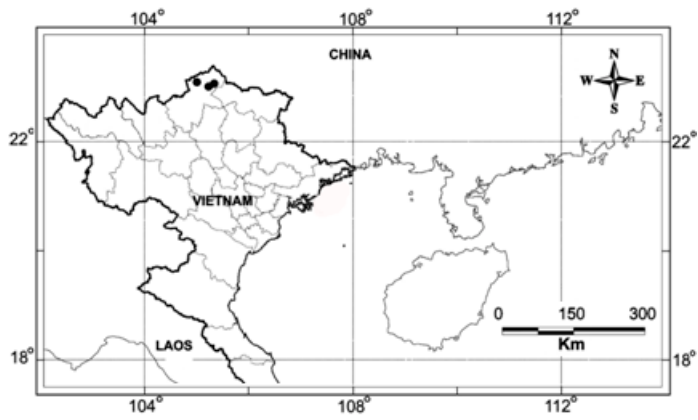
Figure 1. Distribution map of Xanthocyparis vietnamensis Farjon & Hiep in Vietnam.